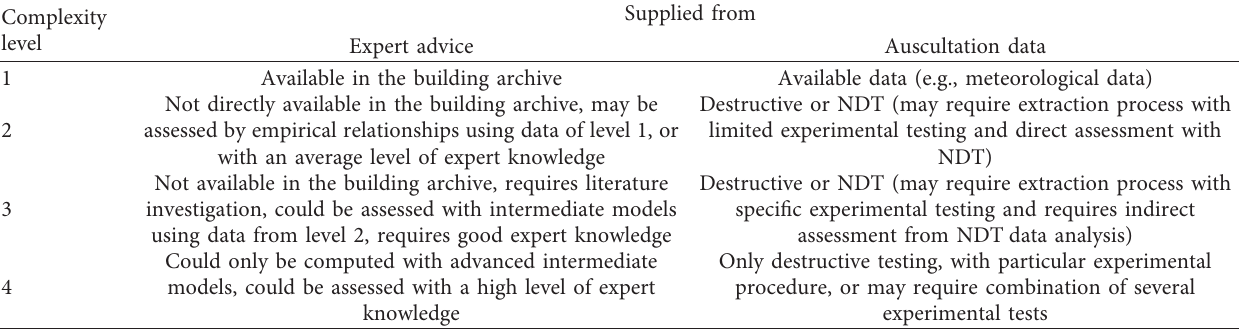
Table 13: Level of complexity with respect to the situation of supplying model’s parameters.